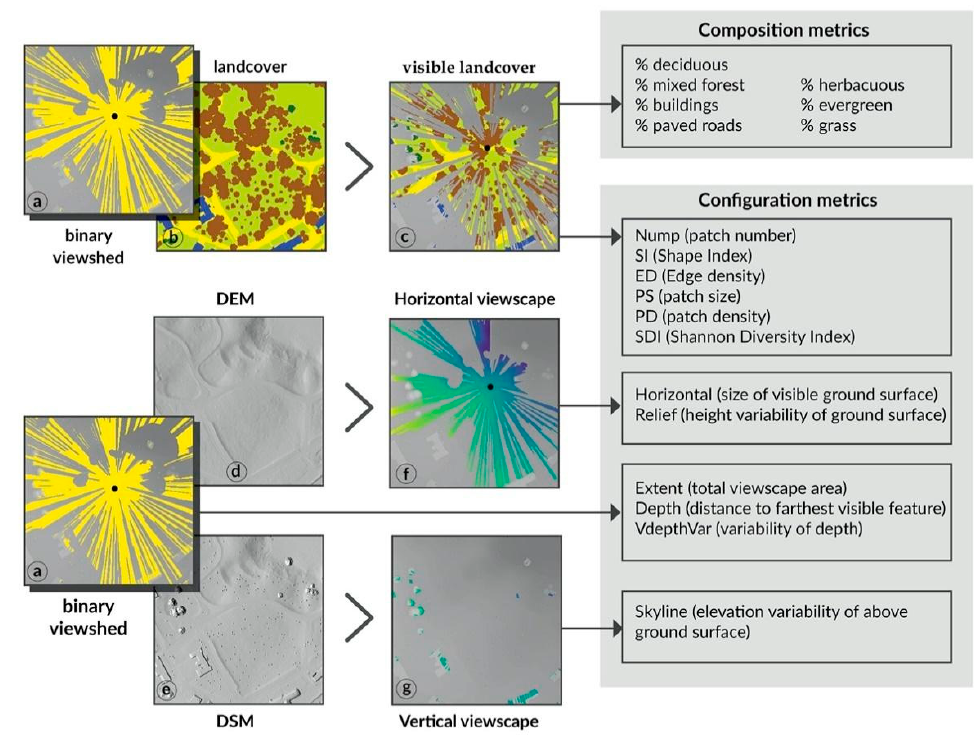
Figure 5. Procedure for computing binary viewshed map ( a ) for a single viewpoint, intersecting the resulting map with landcover ( b ), DEM ( d ) and DSM) to obtain visible landcover map ( c ), horizontal ( f ) and vertical ( g ) viewscape maps, and applying spatial analysis to quantify composition and configuration metrics.